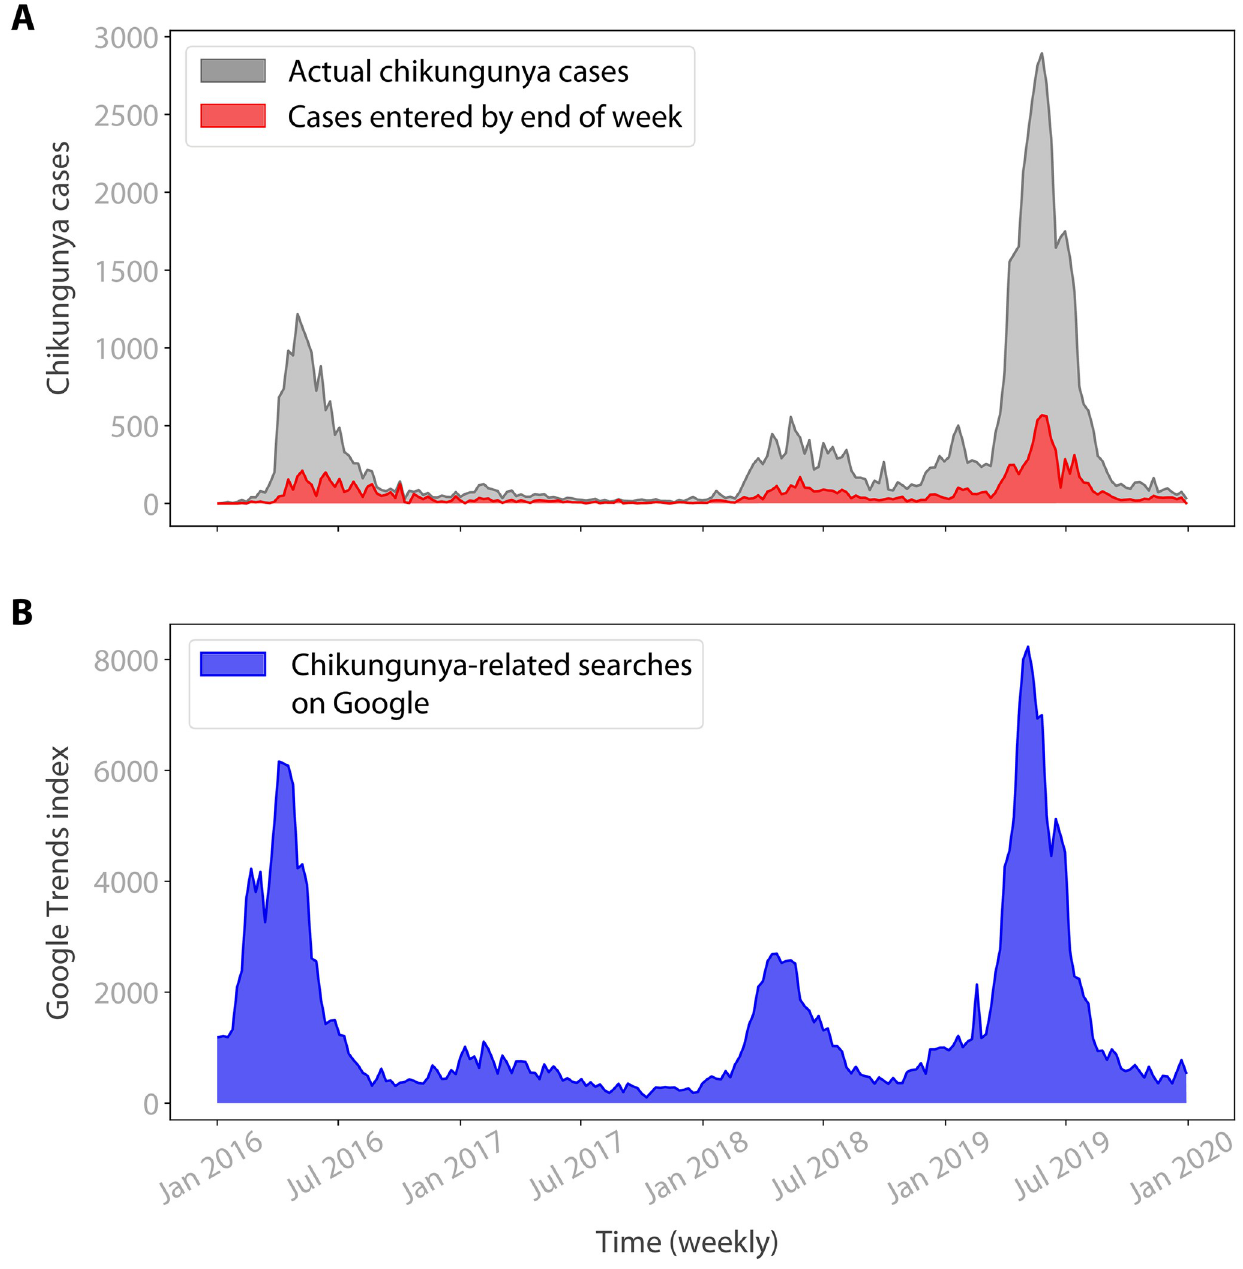
Fig 2. Comparing chikungunya case counts and Google searches over time. A) Time series of chikungunya cases per week in Rio de Janeiro, from 2016 to 2020. The grey series shows the number of cases diagnosed in each week (the notified cases). The red series shows the number of cases diagnosed in a given week that have been entered into the disease surveillance system by the end of that week. Entered cases are an inconsistent fraction of notified cases, and this issue is most severe during the large epidemics in 2016 and 2019. This makes estimating current chikungunya case counts from the official data alone particularly challenging. B) Time series of weekly Google searches for chikungunya-related terms, which are available in real-time. Visually, there is a strong correlation with the case count time series, with Google searches peaking during the large epidemics in 2016 and 2019. The size of the peaks in Google searches also seems to match the size of the epidemics, with the biggest peaks during the 2016 and 2019 epidemics. Google search data may therefore provide a rapid indicator of chikungunya case counts.